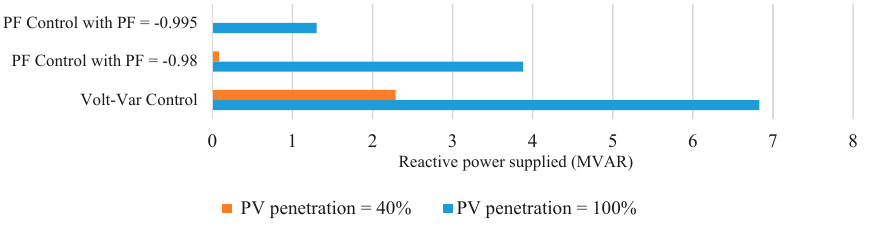
Figure 8. Reactive power supplied by the substation (MVAR)—Only smart inverter control.